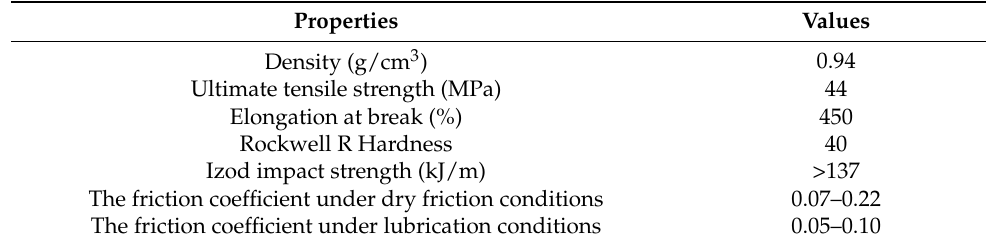
Table 9. The properties of the materials fabricated by the ‘Misumi Group Inc.’ [42].